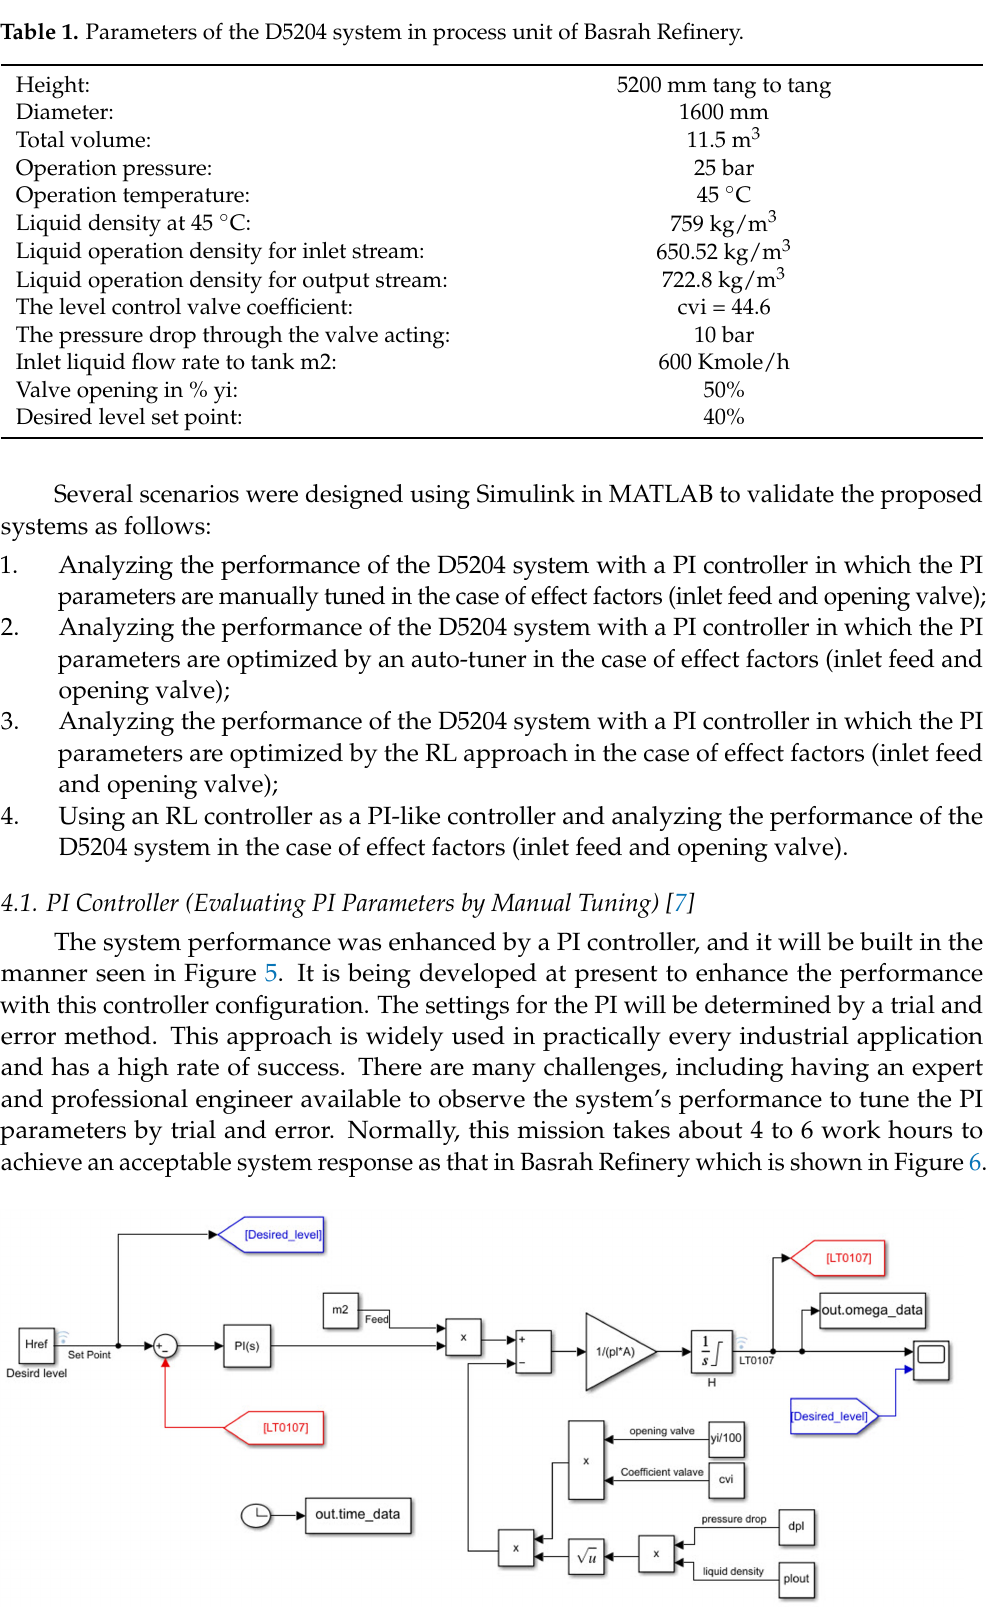
Figure 5. Overall system with PI